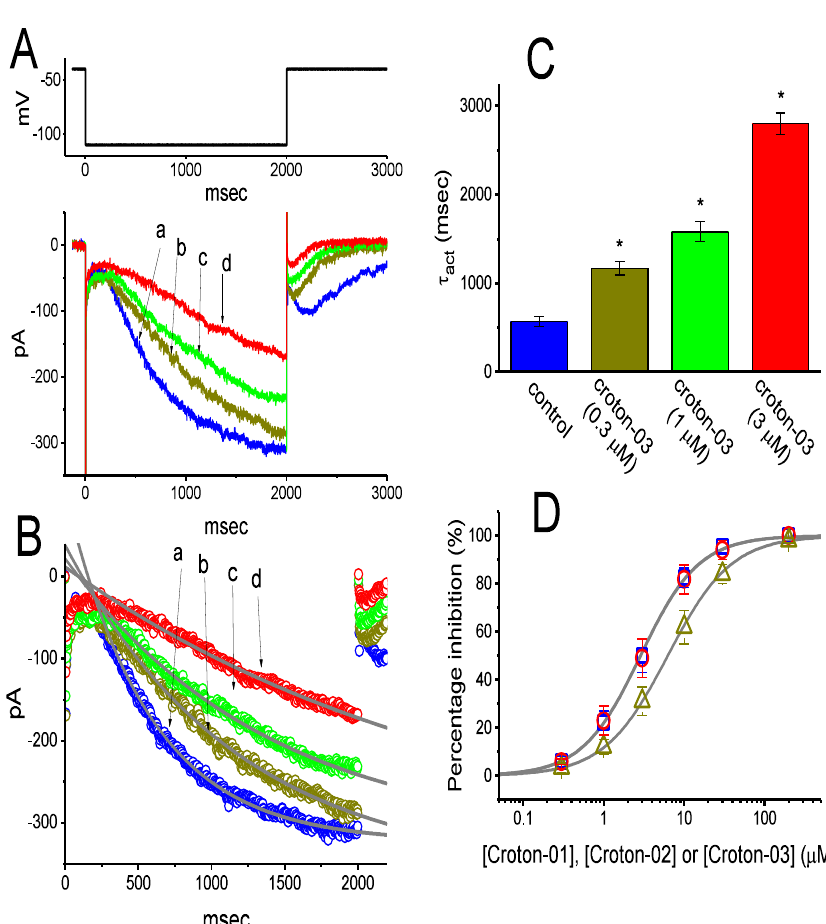
Figure 1. E ff ects of these ent -kaurane-type diterpenoids (i.e., croton-01, croton-02 and croton-03) on hyperpolarization-activated cation current ( I h ) recorded from pituitary GH 3 cells. Cells were bathed in Ca 2 + -free Tyrode’s solution containing 1 µ M tetrodotoxin, the recording pipette was filled with K + -containing solution, and the examined cell was hyperpolarized from − 40 to − 110 mV (as indicated in the uppermost part of (A)). ( A ) Representative I h traces obtained in the control (a), and during the exposure to 0.3 µ M croton-03 (b), 1 µ M croton-03 (c), or 3 µ M croton-03 (d). ( B ) Current trajectories fitted by single exponential (indicated in the gray line). a: control; b: 0.3 µ M croton-03; c: 1 µ M croton-03; d: 3 µ M croton-03. For better illustrations, data points in each trace were reduced by a factor of 10. ( C ) Summary bar graph showing the e ff ect of croton-03 on the activation time constant ( τ act ) of I h . The I h was evoked by step hyperpolarization from − 40 to − 100 mV. ( D ) Concentration-dependent inhibition of I h by croton-01, croton-02, and croton-03 in GH 3 cells. The relations between the percentage inhibition of I h and the concentrations of croton-01 (Ο), croton-02 (Δ) or croton-03 (□) are illustrated. Current amplitudes measured at the end of hyperpolarizing step from − 40 to − 110 mV in the absence or presence of di ff erent concentrations of croton-01, croton-02, or croton-03 were compared with the control values. The continuous lines overlaid were fitted by a modified Hill function (see text for details). The IC 50 values obtained in the presence of croton-01, croton-02, or croton-03 were estimated to be 2.89, 6.25 or 2.84 µ M,